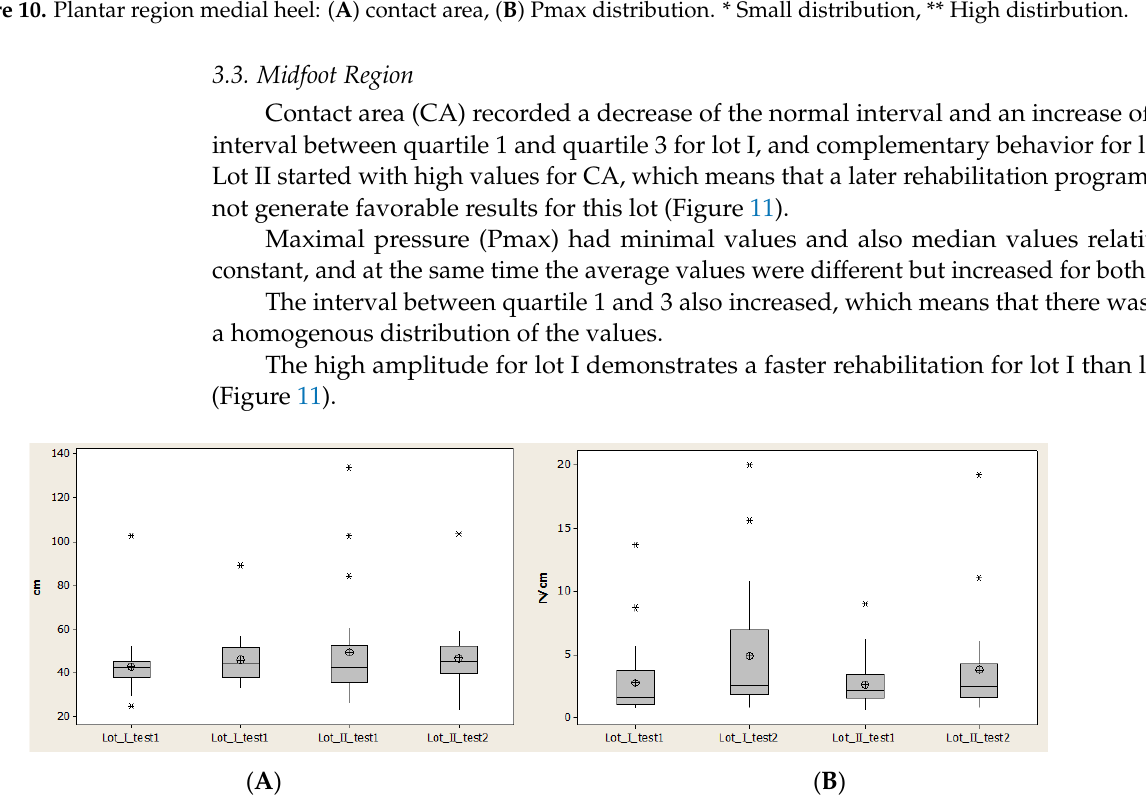
Figure 11. Plantar region midfoot: ( A ) contact area, ( B ) Pmax distribution. * Small distribution, ** High distribution